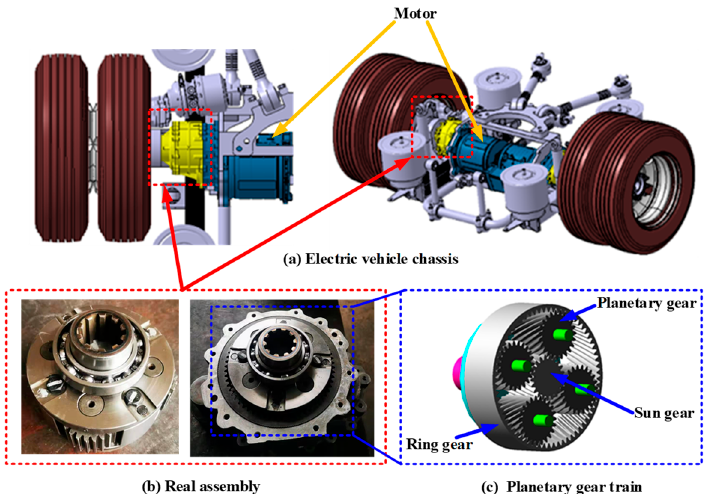
Figure 2. The electric drive system of the vehicle. Table 1. Main parameters of full vehicle